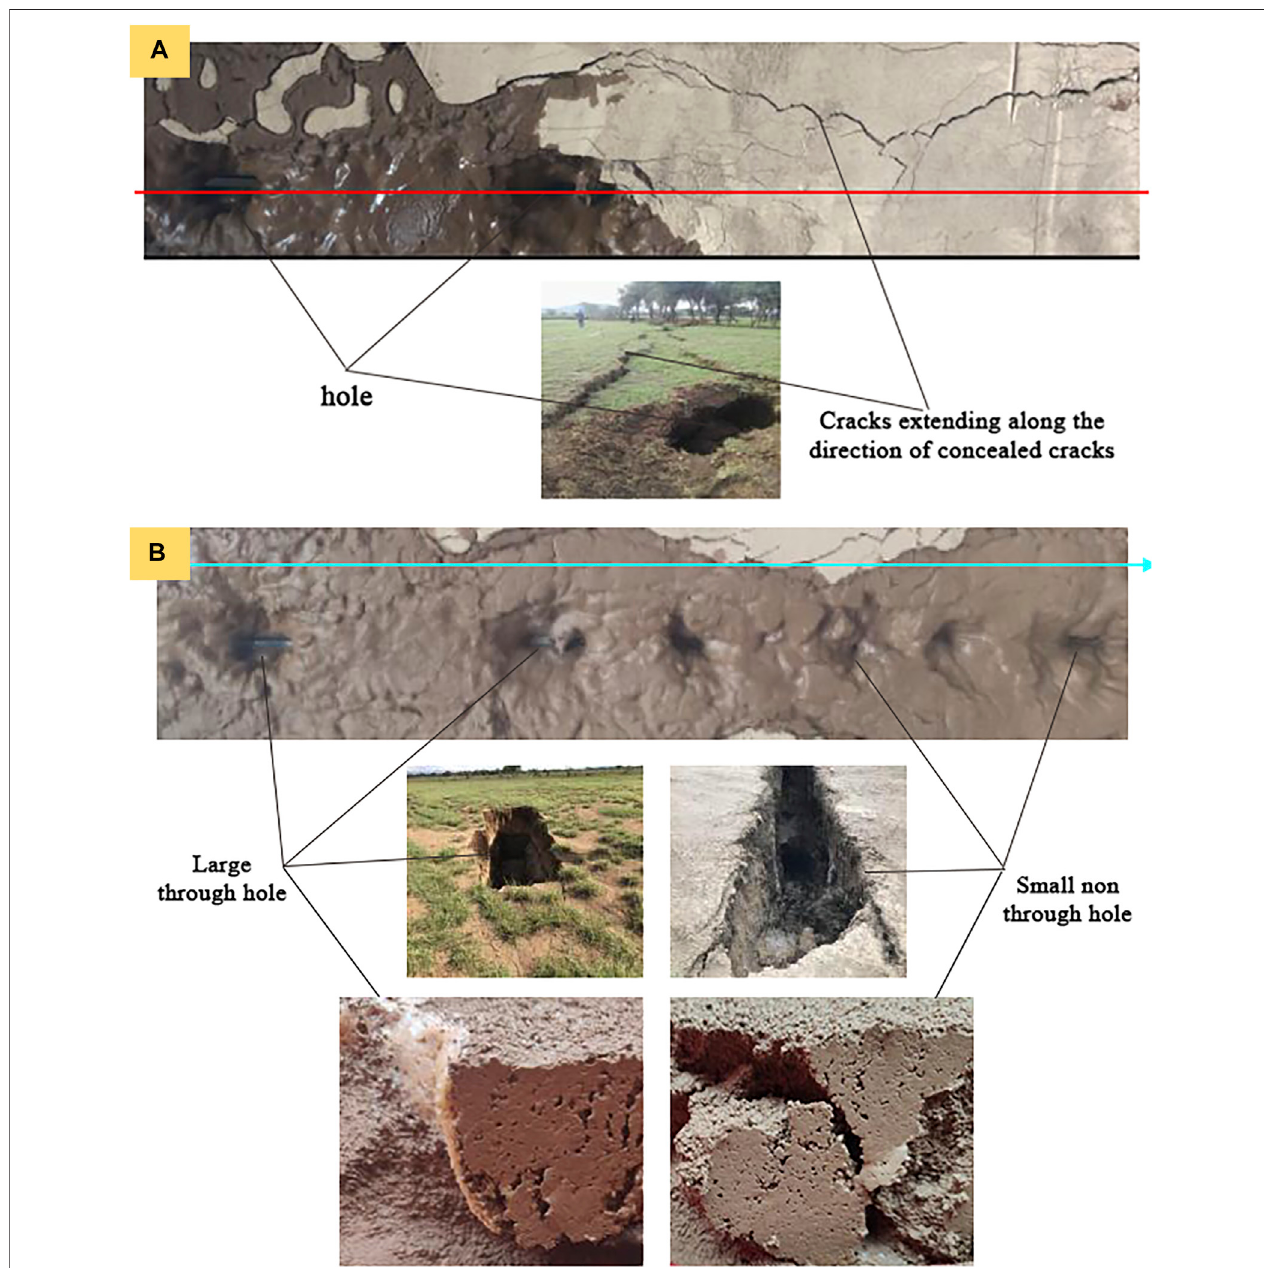
FIGURE 8 | Comparison between loess test results and ground fi ssures with holes. (A) After the fi rst impoundment and drainage (red line is the direction of simulated hidden fi ssures); and (B) after fi ve times of impoundment and drainage (the blue arrow is the fl ow direction of water).